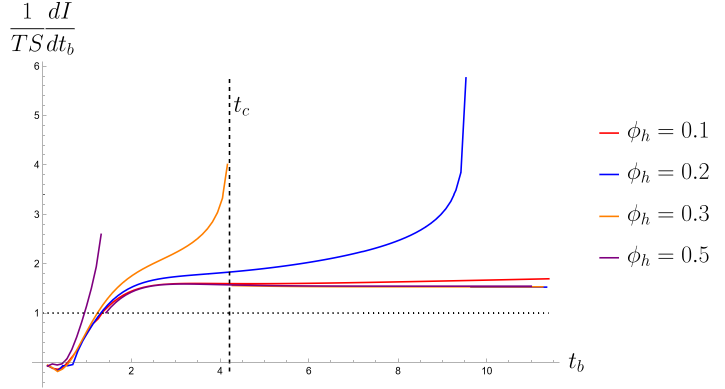
Figure 20 . Time dependence of the action complexity rate in various type U examples for various φ h , with q = 0 , z h = 1 and L ct = 1